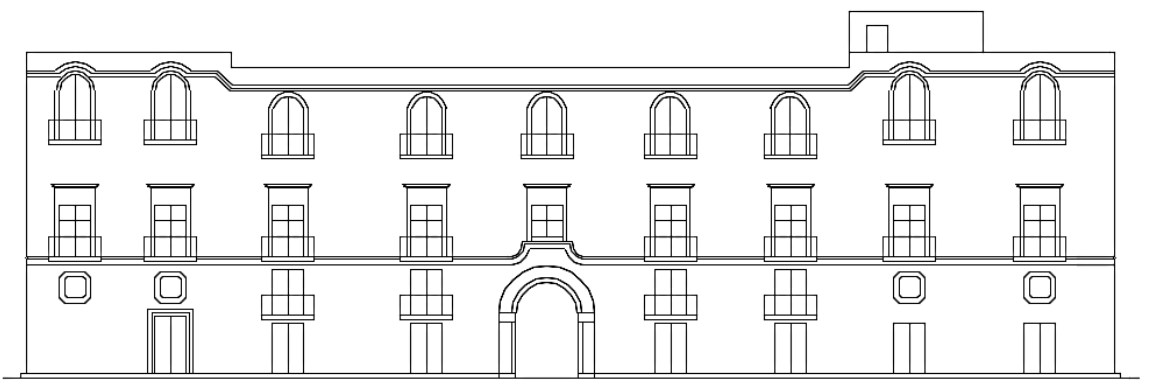
Figure 3. Building aggregate frontal view.